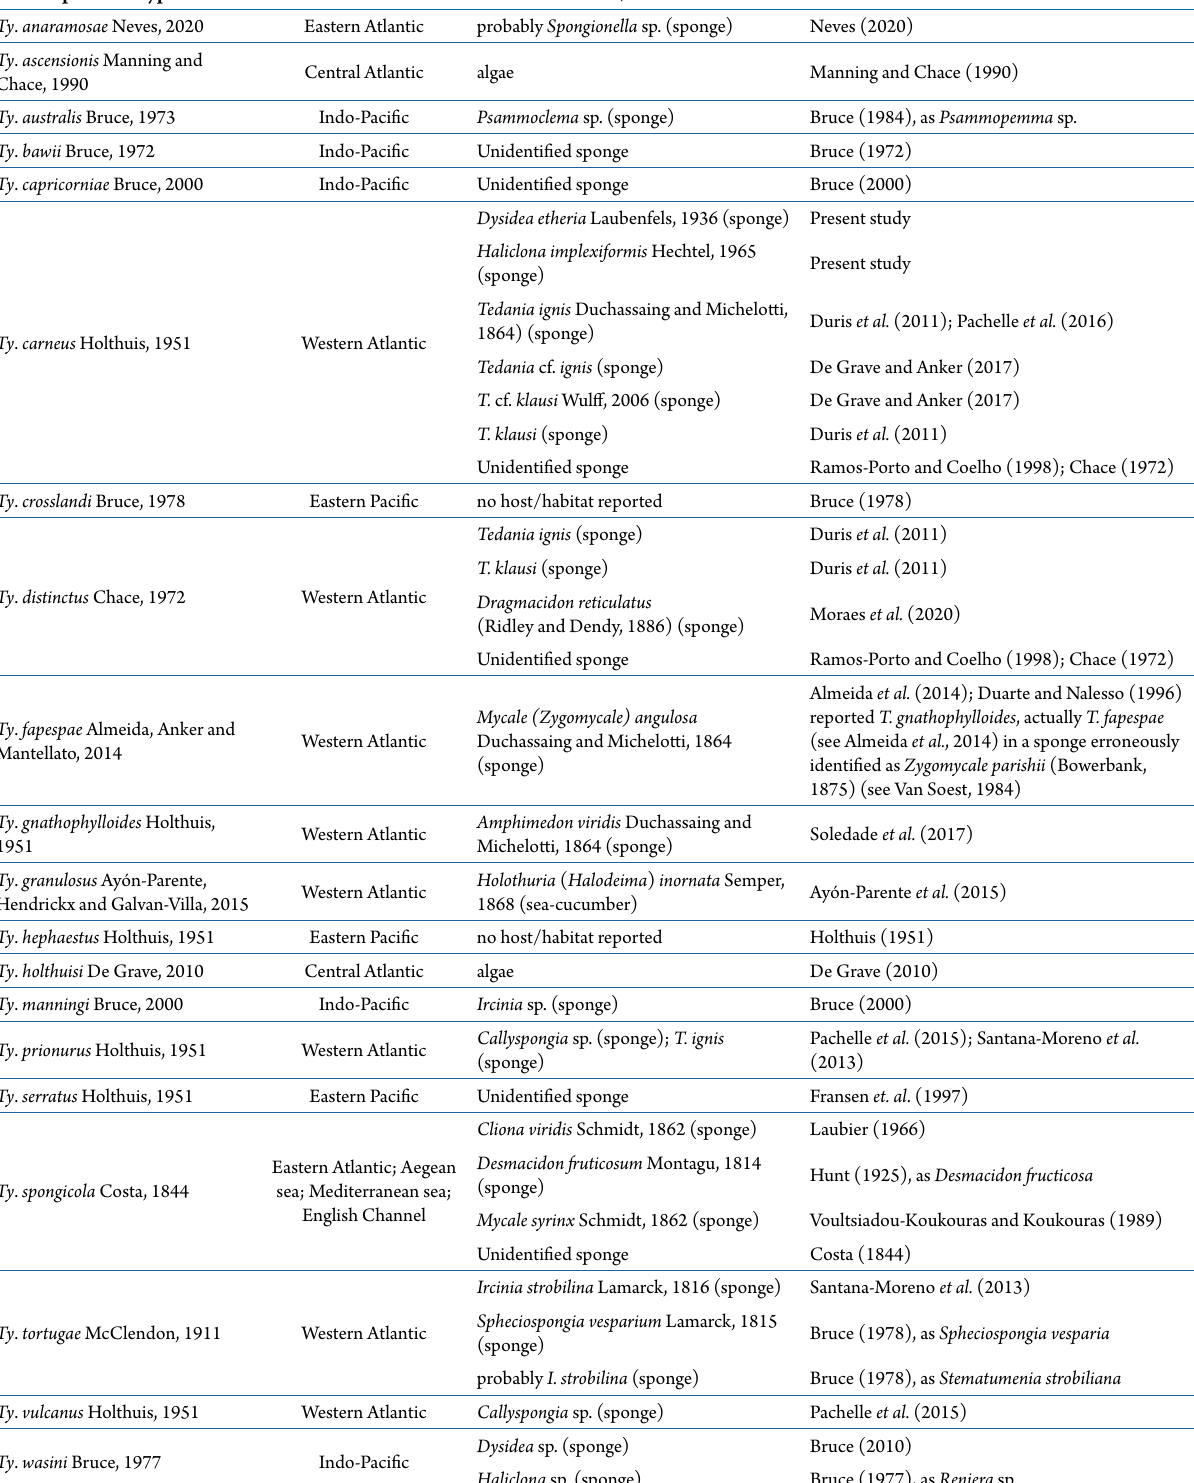
Table 1. Species of palaemonid shrimps of the genus Typton Costa, 1844 and their hosts/habitats. Species of